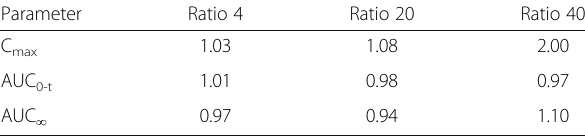
Table 2 Effect of alcohol on pharmacokinetic parameters of EMBEDA (fasted state) (data from reference (Johnson et al. 2012))